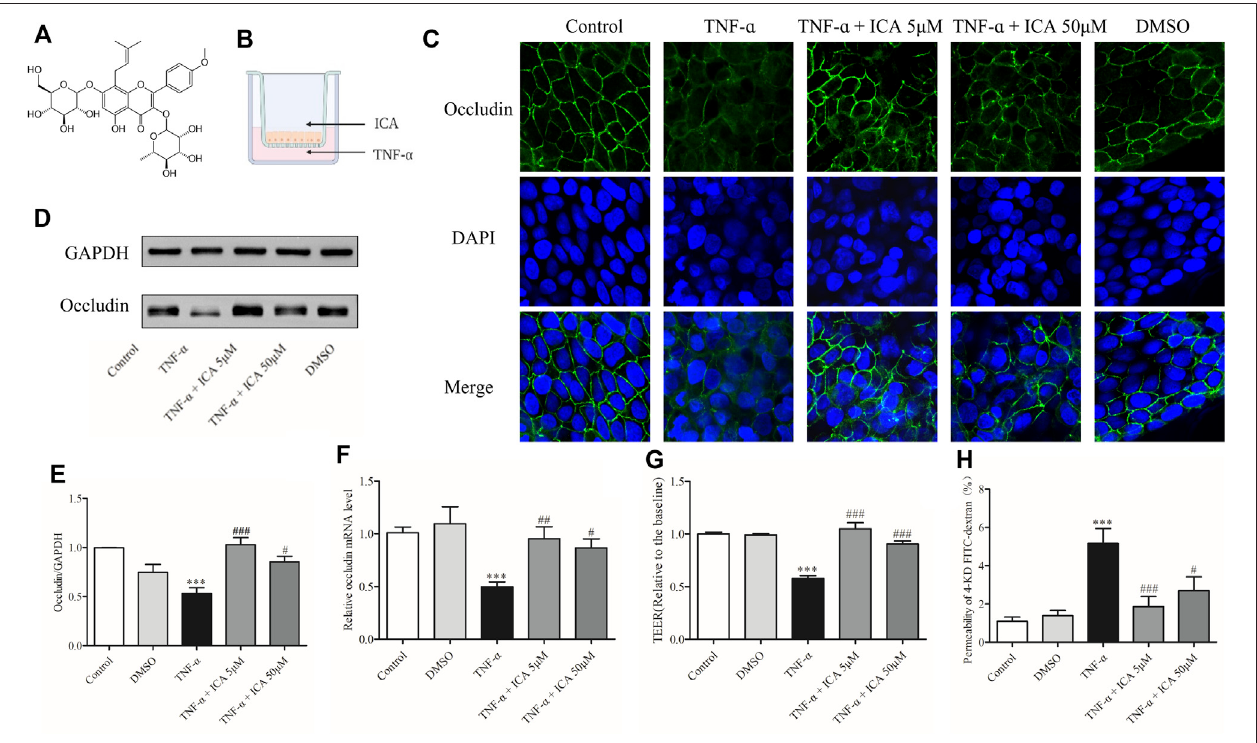
FIGURE6| ICAreversedthedecreaseinOccludinexpressionandbarrierdegradationofCaco-2cellmonolayerscausedbyTNF- α stimulation. (A) Thestructureof ICA. (B) PatternsofadministrationofTNF- α andICA. (C) ThechangesofOccludinweredetectedbyIF(800×).IntheICAgroup,5 μ MICAor50 μ MICAwasaddedtothe APsidefor30 min,and20 ng/mlTNF- α wasaddedtotheBPsideforco-treatmentfor24 h.IntheDMSOgroup,1 μ l/mlDMSOwasaddedtotheAPsidethentreatment for24.5 h.TheexpressionofOccludinprotein (D,E) andmRNA (F) wasdetectedbyWesternblotorqPCR. (G) TEERand (H) 4-KDFITC-dextrandetectedchanges in barrier permeability of monolayers. *** p < 0.001 vs. Control group. # p < 0.05 vs. TNF- α group. ## p < 0.01 vs. TNF- α group. ### p < 0.001 vs. TNF- α group n = 8 –